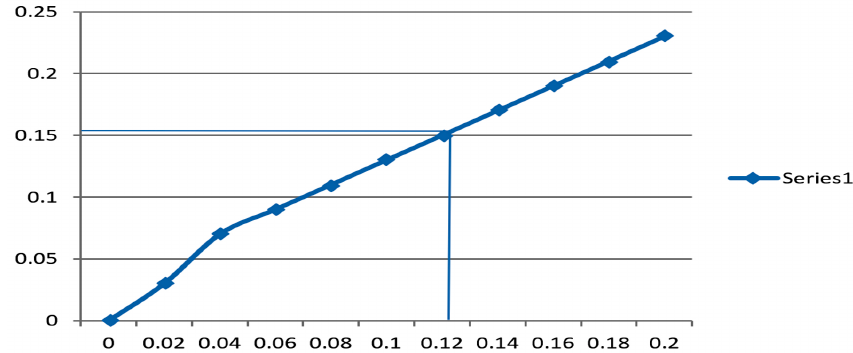
Fig. 4. Protease activity assay. ( Concentration of tyrosine (µ mole )